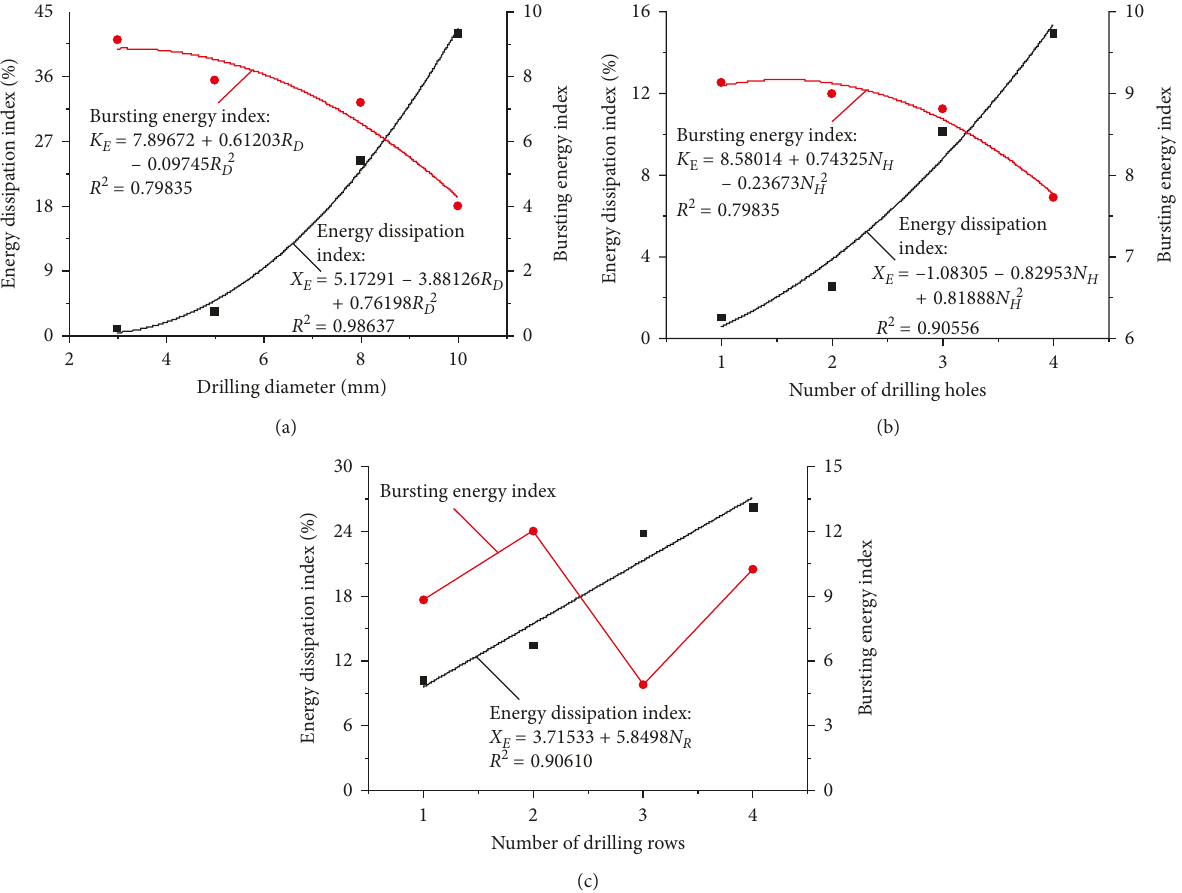
Figure 11: Energy evolution curves of specimens with various drilling arrangements. (a) Different drilling diameters. (b) Different numbers of drilling holes in one row. (c) Different numbers of drilling rows.